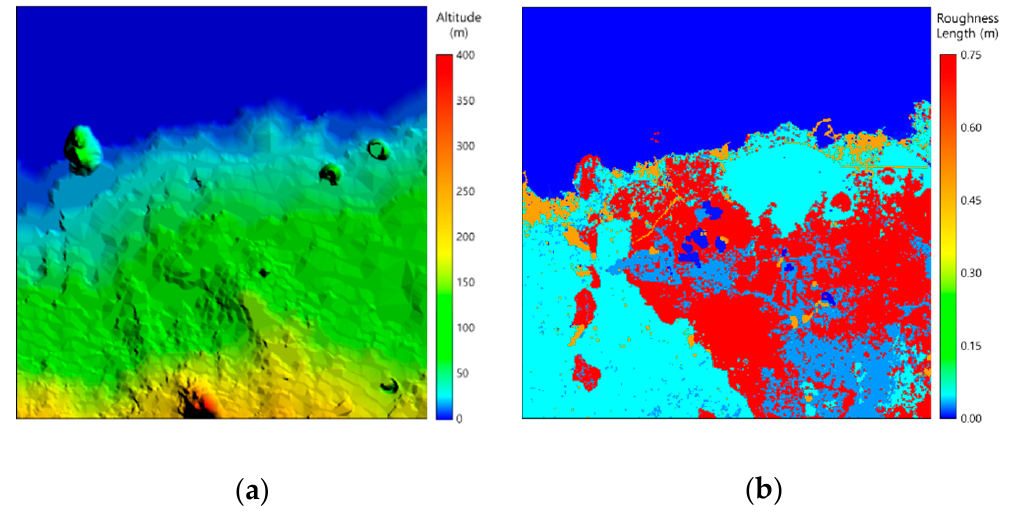
Figure 4. Terrain model of the target wind farm L ( a ) elevation; ( b ) roughness length.